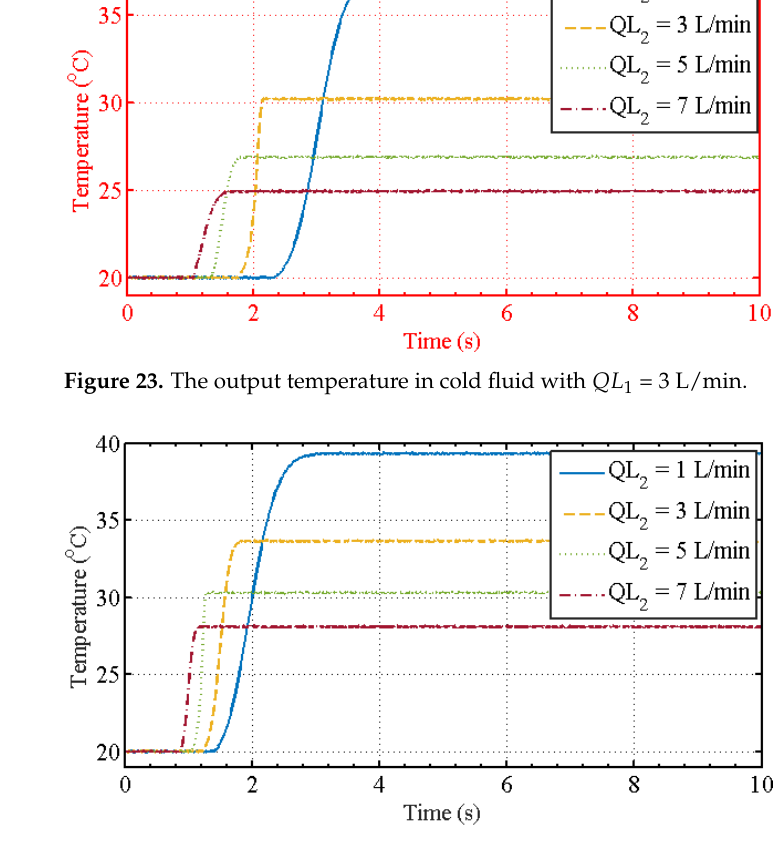
Figure 24. The output temperature in cold fluid with QL 1 = 5 L/min.